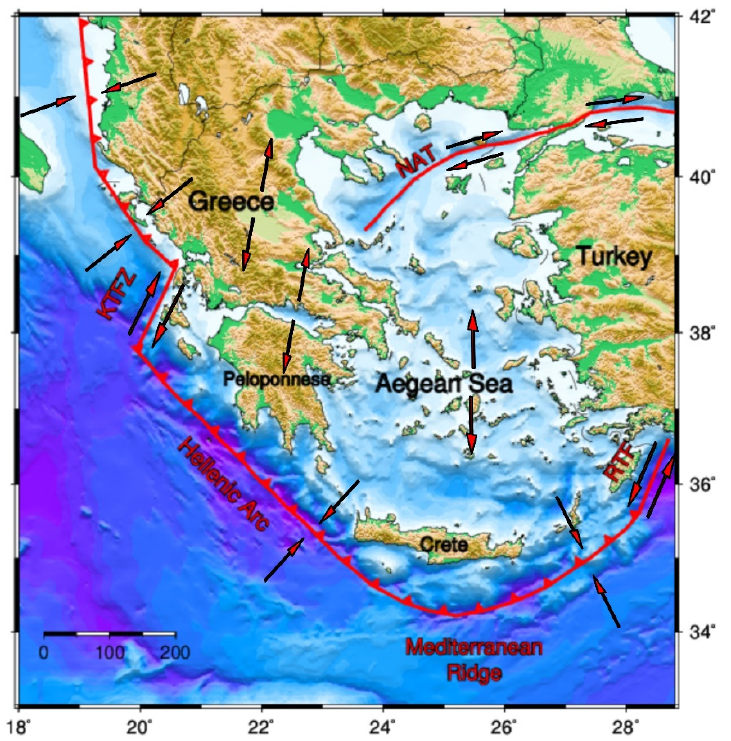
Figure 2. The main geodynamic features of Greece. Red lines denote the active boundaries and the red arrows the relative motions (NAT: North Aegean Trough; KTFZ: Kefalonia Transform Fault Zone; RTF: Rhodes Transform Fault).